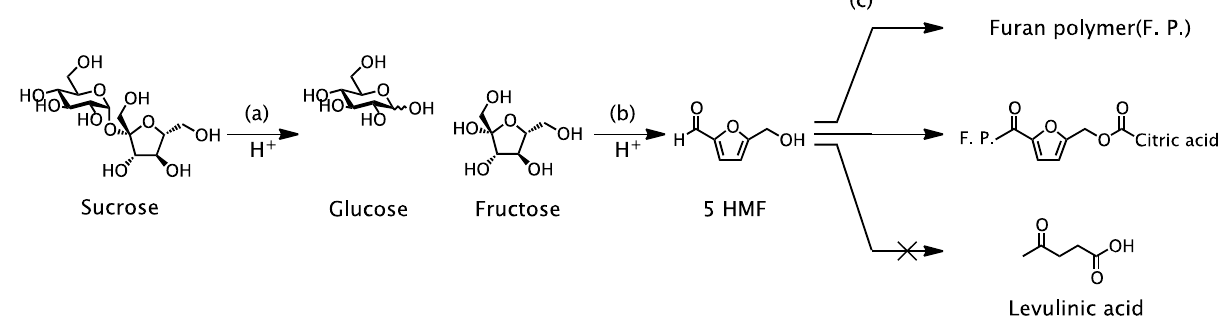
Figure 3. HSQC-NMR spectra in the aromatic region of the wood (Japanese cedar) ( a ) and the su- crose/citric acid type adhesive wood-based molding (W80) ( b